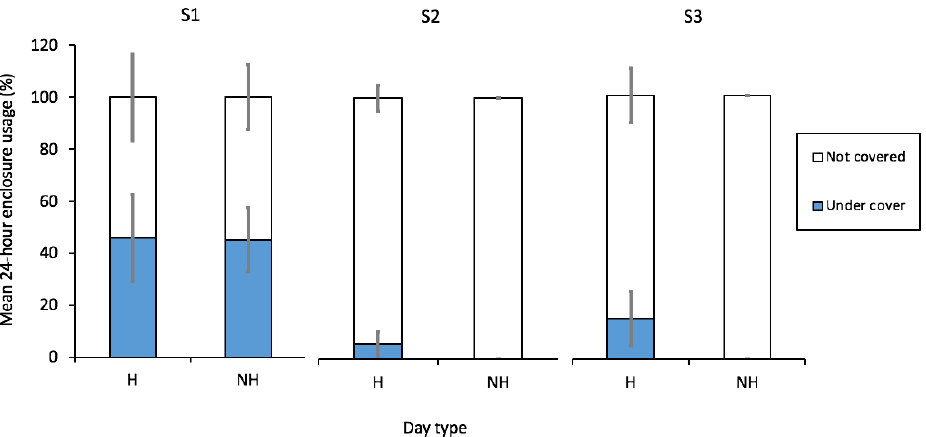
Figure 1. Mean ± SE percentage (%) of handling days (H) and no-handling days (NH) that S1 (8H, 6NH), S2 (6H, 8NH) and S3 (4H, 2NH) spent under cover and not covered.